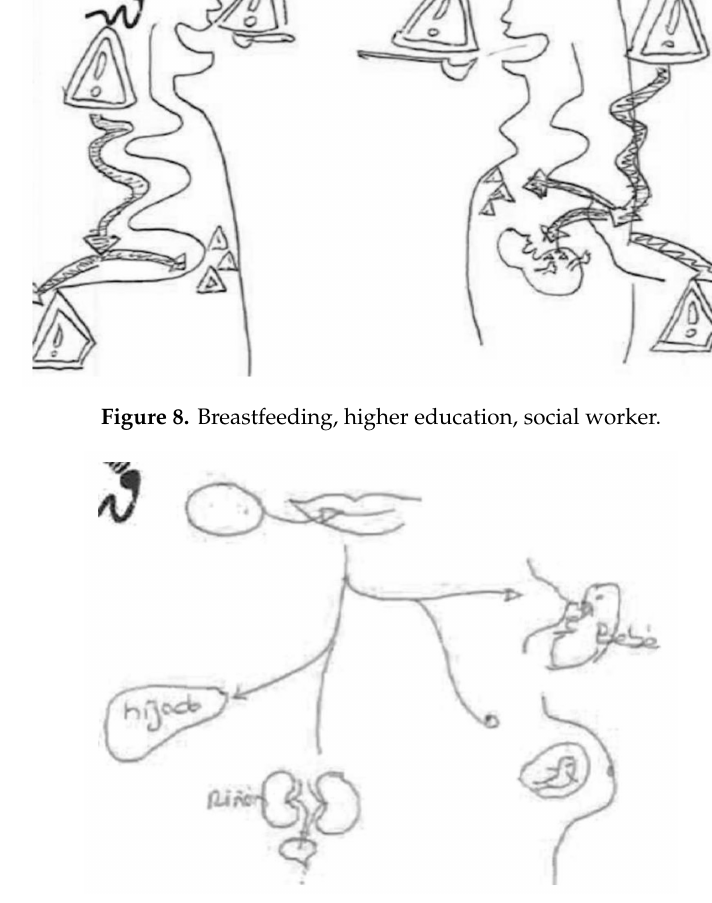
Figure 9. Breastfeeding, university education,